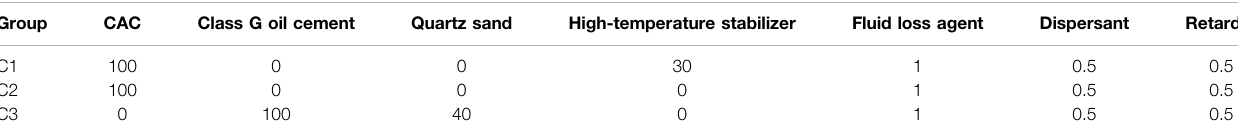
TABLE 4 | Formula of cement slurry (mass fraction %).